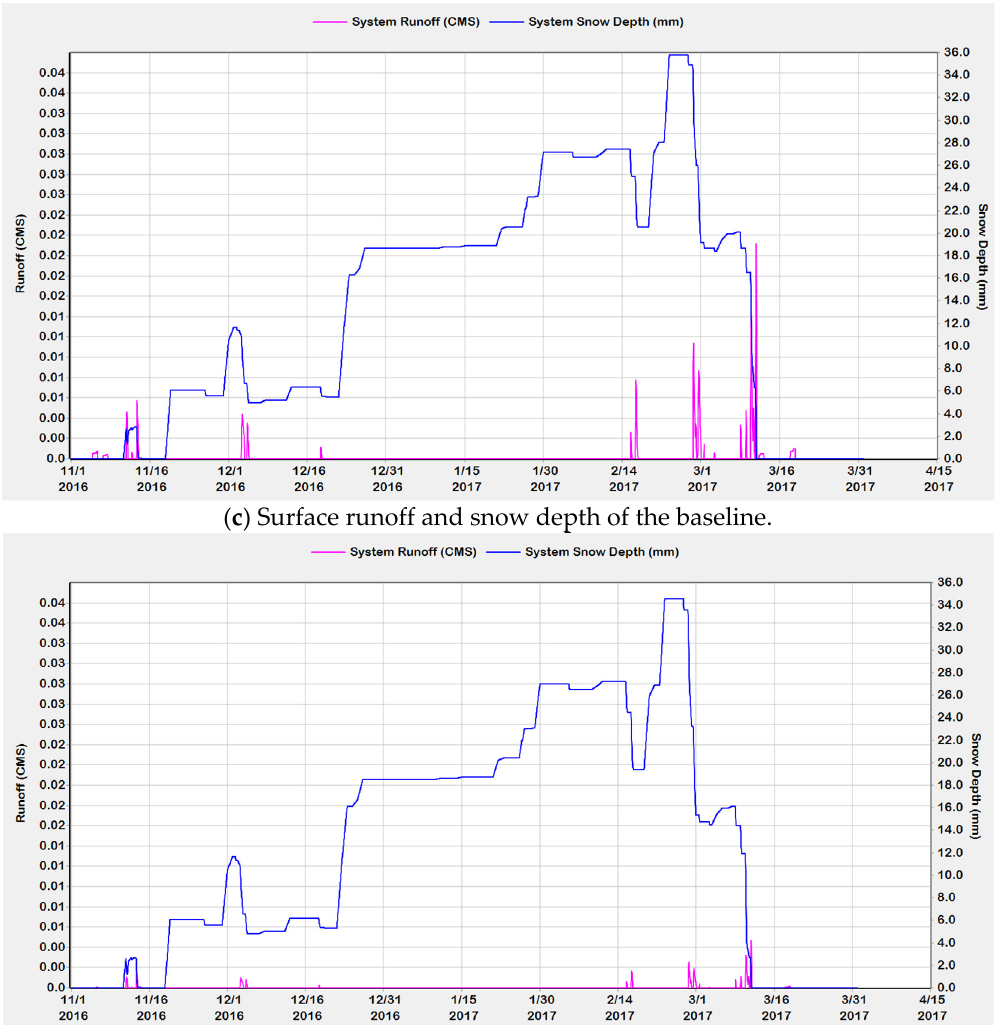
Figure 11. Relationship between the infiltration and snow depth in the baseline ( a ) and LID scenario ( b ), and the relationship between the surface runoff and snow depth in the baseline ( c ) and LID scenario ( d ).